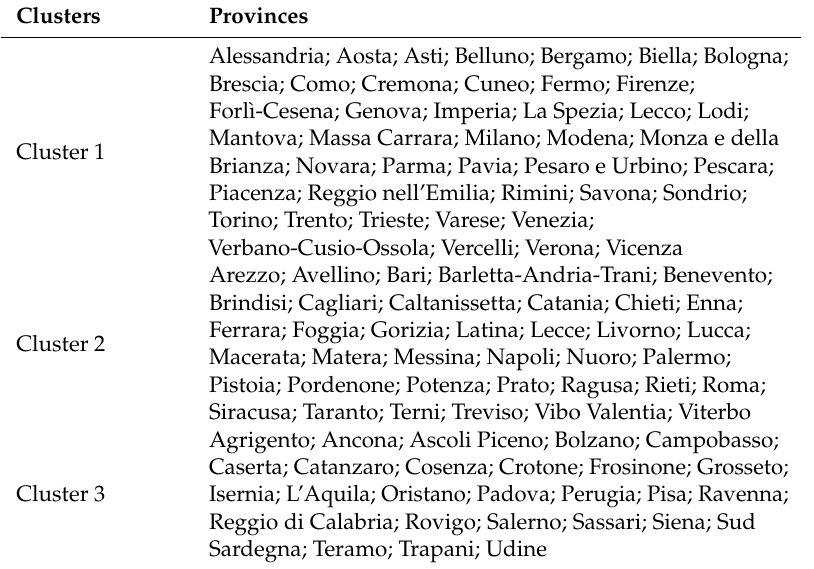
Table 5. Hierarchical clusters’ composition of